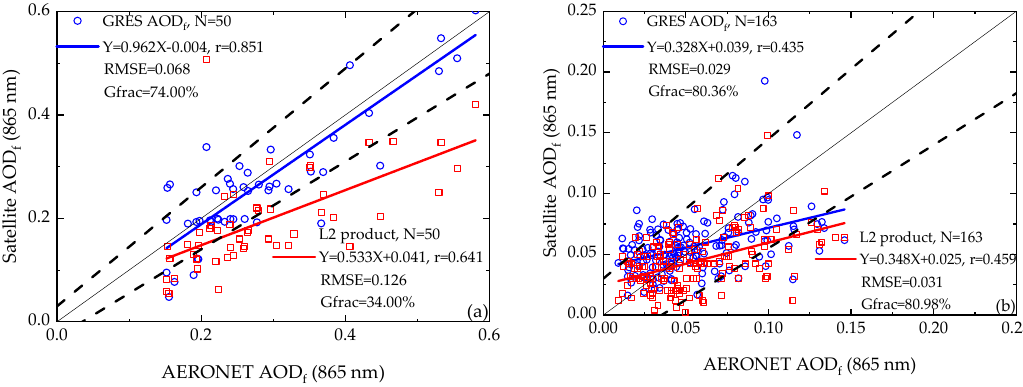
Figure 8. The scatter plots for the GRES AOD f and PARASOL L2 product against AERONET measurements. ( a ) is for the case of AOD f at 865 nm ≥ 0.15, ( b ) is for the case of AOD f at 865 nm < 0.15.